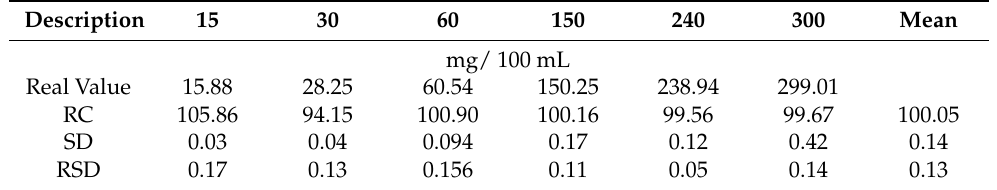
Table 8. Recovery rate (RC,%), absolute (SD) and relative (RSD,%) standard deviation of six model solutions varying in inulin concentrations from 15 to 300 mg/100 mL, measurements performed on five different days ( n = 5), column Polypore H